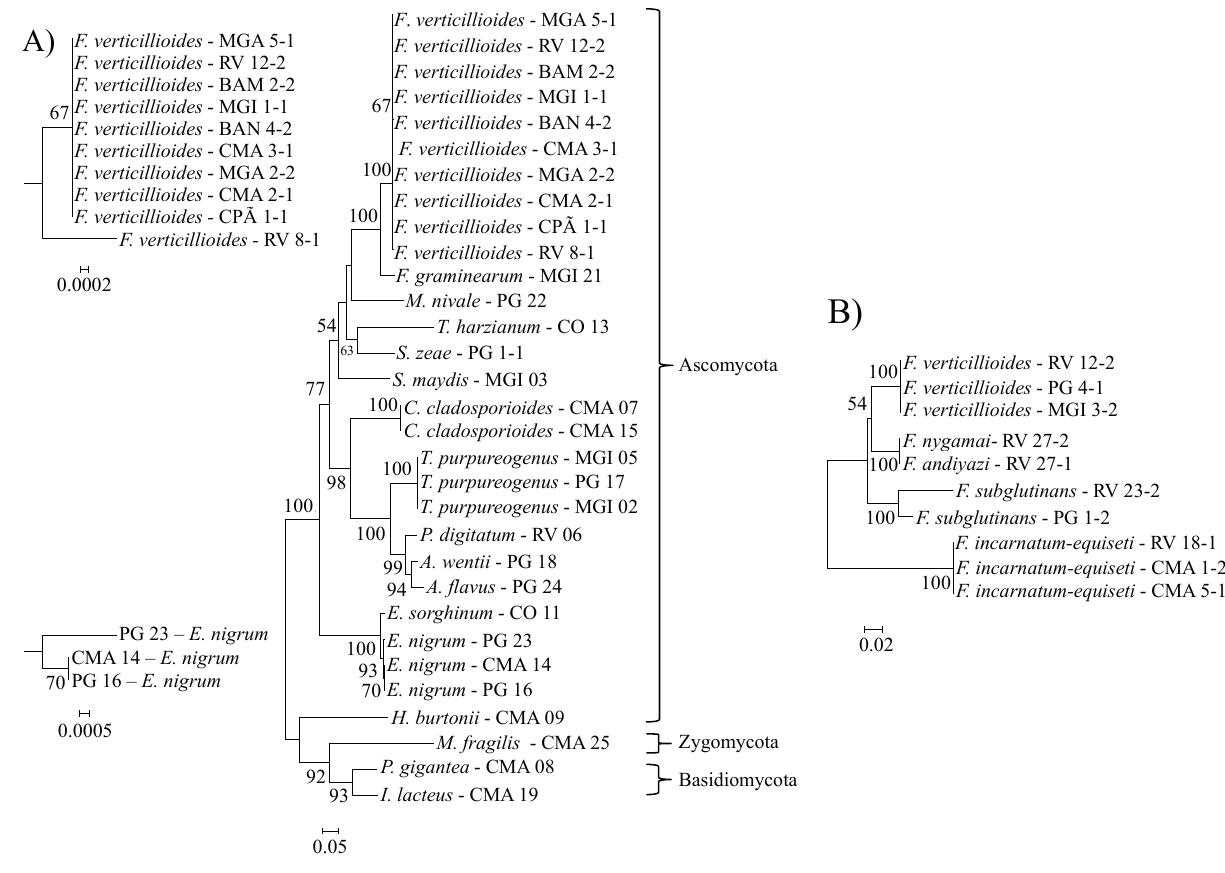
Figure 1. The evolutionary history of the rDNA ( A ) and TEF1 α ( B ) sequences. The optimal trees with the sum of branch length = 2.85730321 for rDNA and 0.36769626